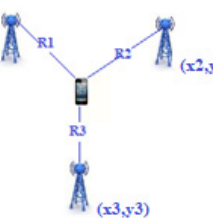
Figure 4. Time of Figure 4. Time of arrival.